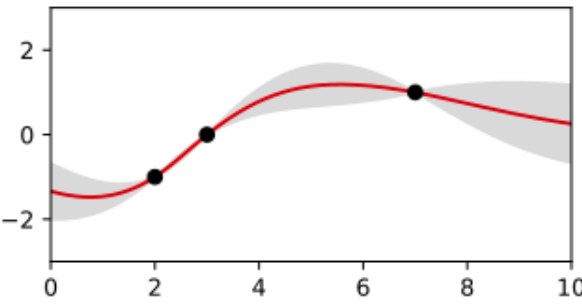
Figure 2. Promising position, according to a F